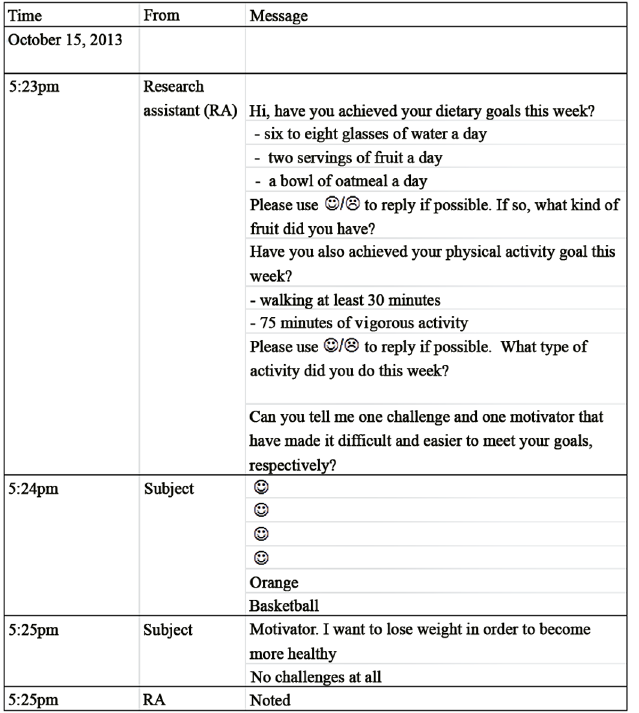
Fig 3. Sample of a text message interaction with an intervention subject. A sample semi-personalized health message interaction log recording interactions between the research assistant and a subject in the internet (IT) intervention